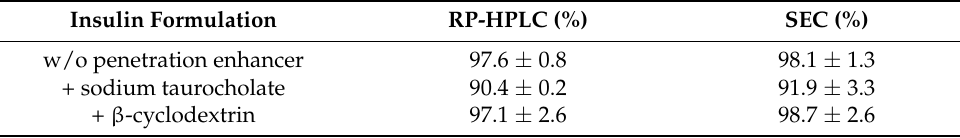
Table 3. Percentage of the theoretical insulin content determined by RP-HPLC and